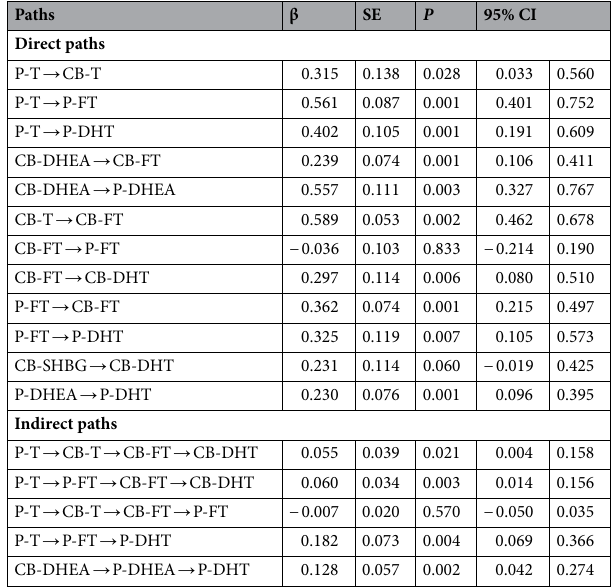
Table 4. Coefficients of association path models between prenatal androgens and cord blood androgens in female neonates. P-T prenatal testosterone, P-FT prenatal free testosterone, P-DHT prenatal